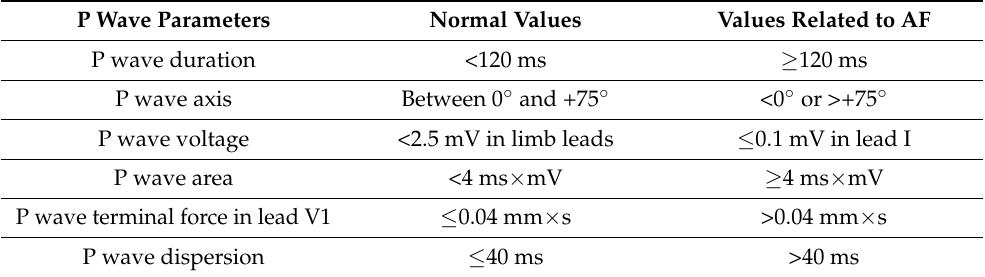
Table 1. P wave parameter abnormalities related to atrial fibrillation. P Wave